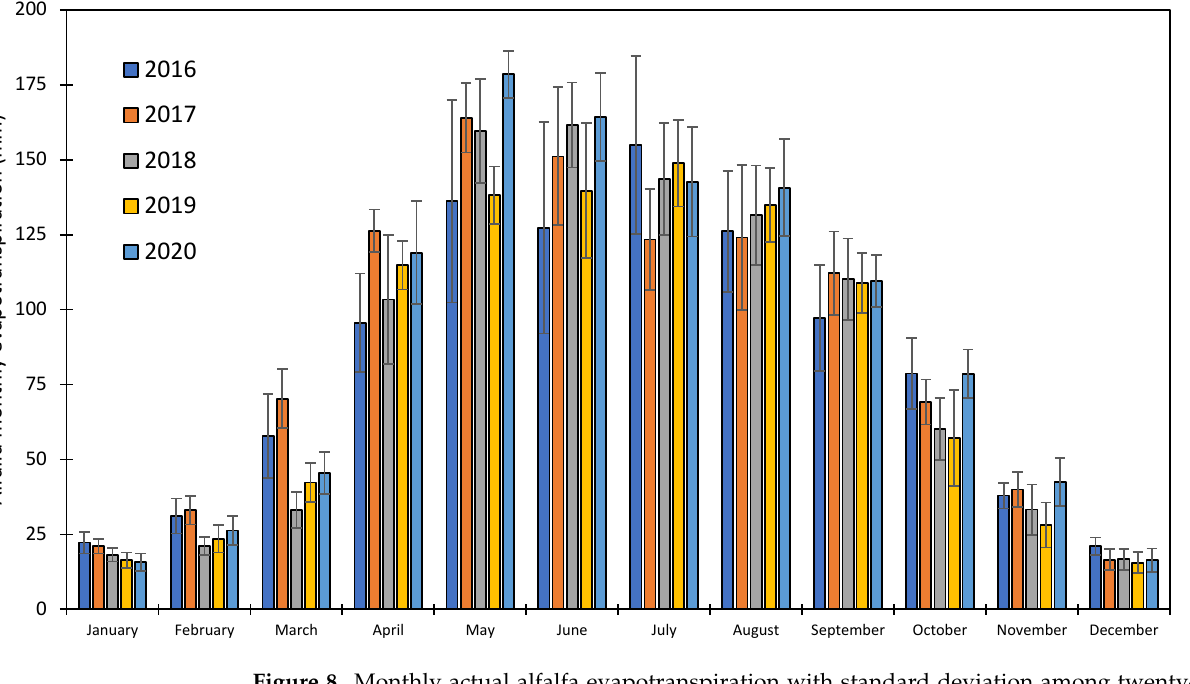
Figure 8. Monthly actual alfalfa evapotranspiration with standard deviation among twenty-two alfalfa fields for the 2016–2020 period under center-pivot irrigation.